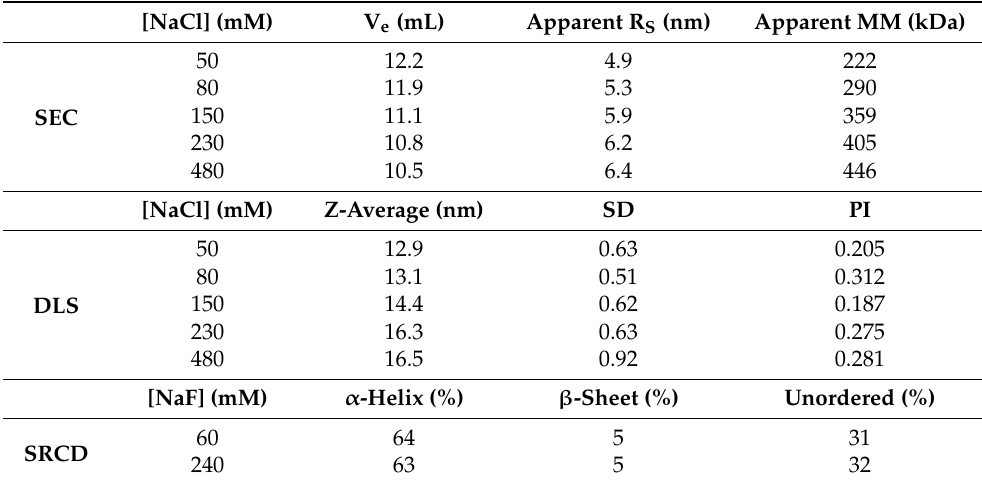
Figure 3. SRCD circular dichroism spectra of DgrDps WT in 10 mM MOPS pH 7.0 buffer, containing either 240 mM NaF (full circles) or 60 mM NaF (empty circles) at 25 °C. Solid line represents reconstructed spectral data from DichroWeb analysis. Table 1. Macromolecular structure characteristics of DgrDps WT when varying the ionic strength of the buffer, as per SEC, DLS, and SRCD analysis.